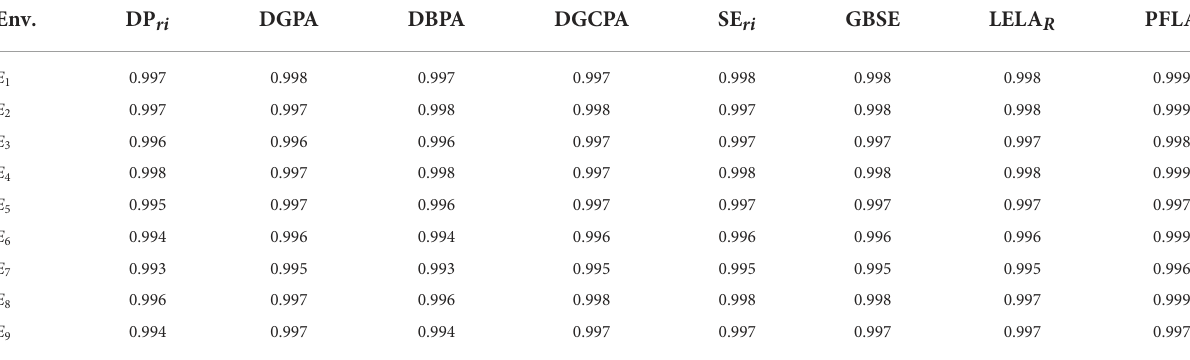
TABLE 2 Accuracy ( number of correct convergences/number of experiments ) of the compared algorithms in environments E 1 to E 9 , when using the “best” learning parameters (250,000 experiments were performed for each scheme in each environment). Env.